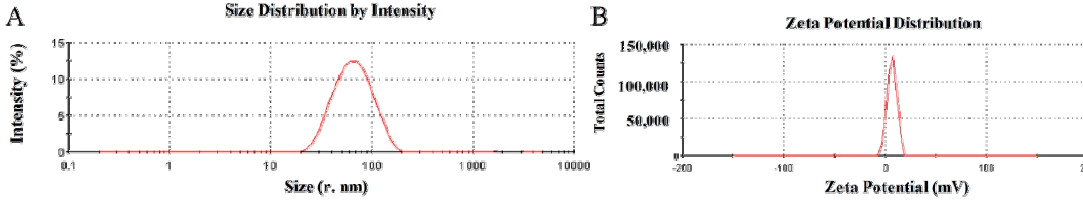
Figure 1. ( A ) the particle size and ( B ) ξ -potential of prepared Tf-LPs. The particle size of Tf-LPs was 128.64 nm. ξ -potential of Tf-LPs was 6.81 mV. Abbreviations: LPs, DOX-loaded liposomes; Tf-LPs, DOX-loaded Tf-liposomes.